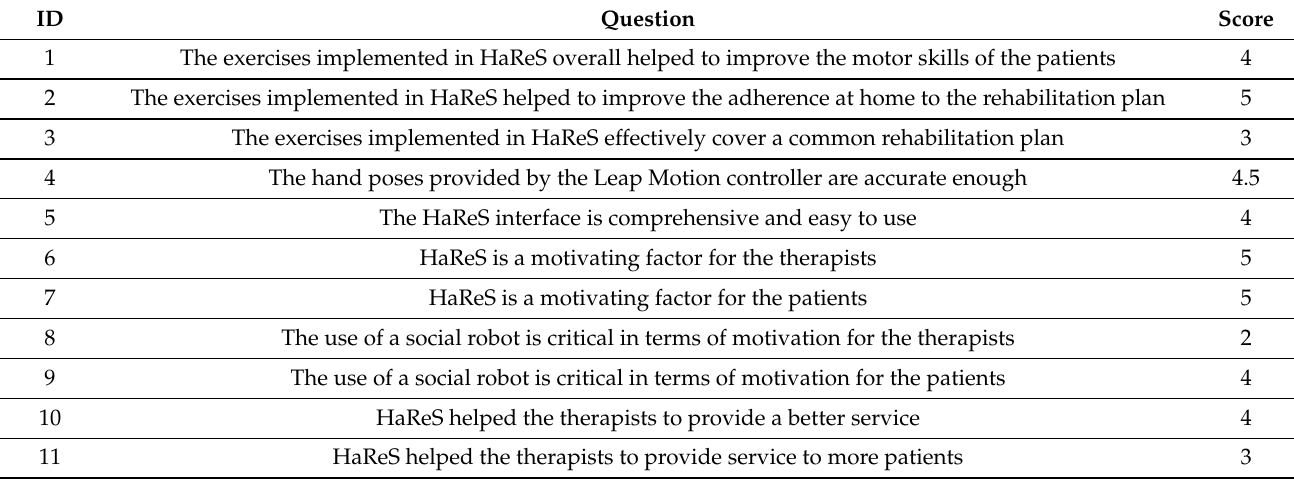
Table 1. Questions and corresponding scores of the survey conducted in two different facilities for motor and cognitive